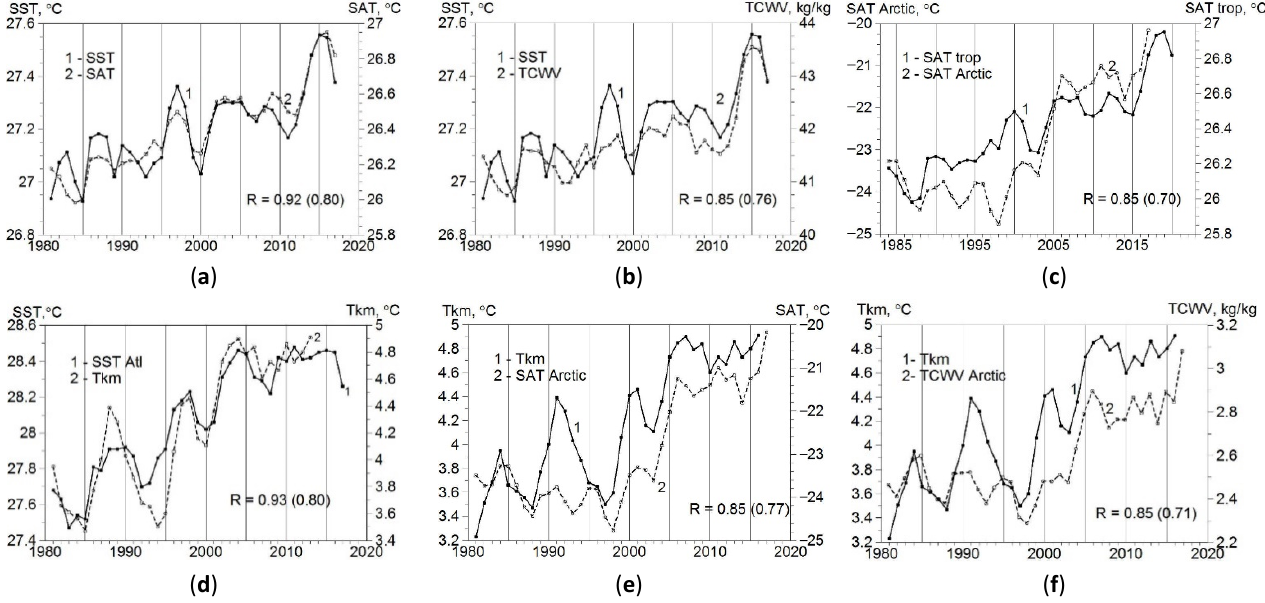
Figure 8. Variations of SST, atmospheric parameters at low latitudes and SST, sea ice, atmospheric parameters in the Arctic. Upper panel ( a ) 1—SST (10 ◦ S–10 ◦ N, August), 2—SAT (0–25 ◦ N, October); ( b ) 1—SST (10 ◦ S–10 ◦ N, August), 2—TCWV (0–25 ◦ N, October); ( c ) 1—SAT (0–25 ◦ N, October), 2—SAT (70–87.5 ◦ N). Lower panel: ( d ) 1—SST (Atl (5–25 ◦ N, 60–20 ◦ W), 2—Tkm; ( e ) 1—Tkm; 2—SAT (70–87.5 ◦ N); ( f ) 1—Tkm; 2—TCWV (70–87.5 ◦ N). Series are smoothed with a 3-year window. R—correlation coefficient, in brackets—between unsmoothed